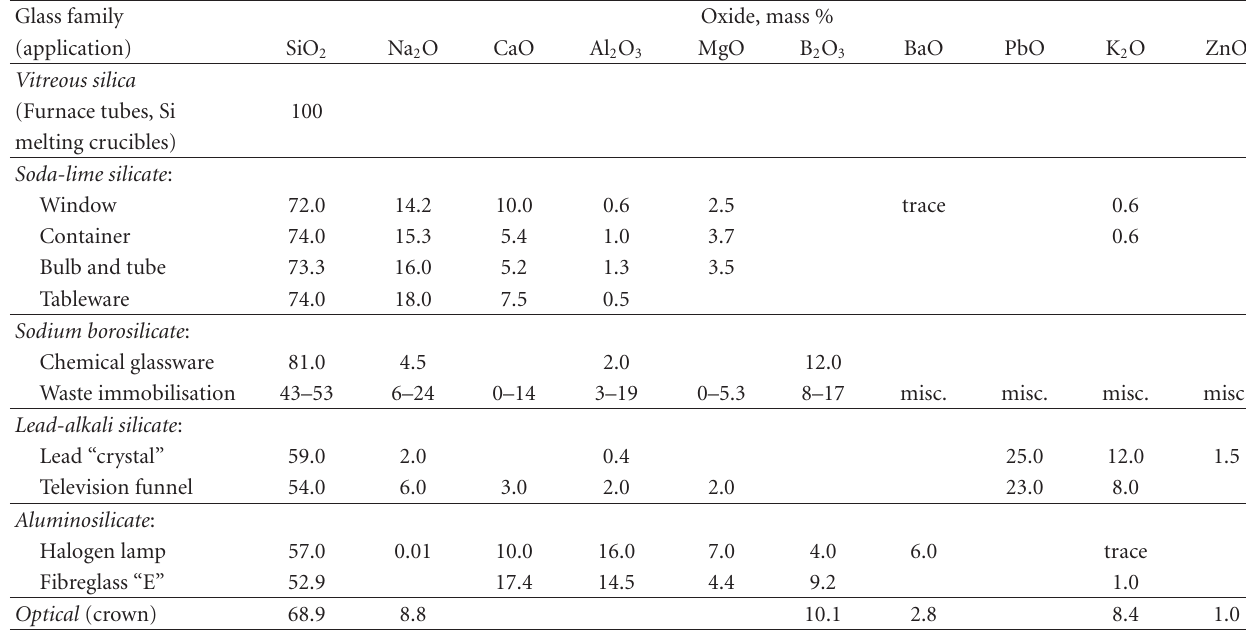
Table 1: Commercial oxide glass